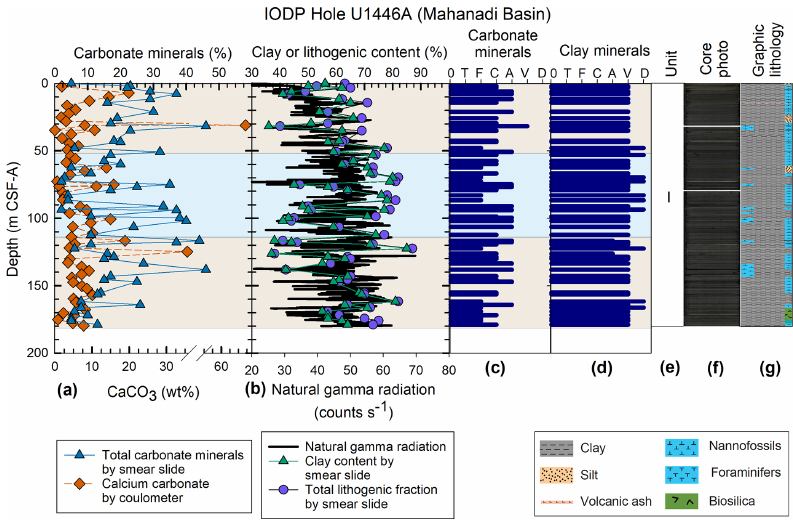
Figure 5. Downcore data from Site U1446. (a) Comparison of carbonate mineral percentages estimated from smear slides (blue triangles) taken from within the major lithologies to CaCO 3 measured by carbonate coulometer (orange diamonds). (b) Comparison of the clay fraction (green triangles) and total lithogenic fraction (purple circles) estimated from smear slides to natural gamma radiation measured by whole round core scanning (black line). The colored zones indicate the smear slide estimates from two observers. The colored zones indicate the smear slide estimates from two observers. Panels (c) and (d) are the abundance categories of total carbonate minerals and total clay minerals, where 0 is none, T is trace ( < 1%), F is few (1% to 9%), C is common (10% to 24%), A is abundant (25% to 40%), V is very abundant (41% to 74%), and D is dominant ( > 75%) as presented in the IODP 353 Proceedings. (e) Lithostratigraphic units from visual core description. Unit I is clay with nannofossils, foraminifers, and biosilica. (f) Core photo composite. (g) Lithologic column.